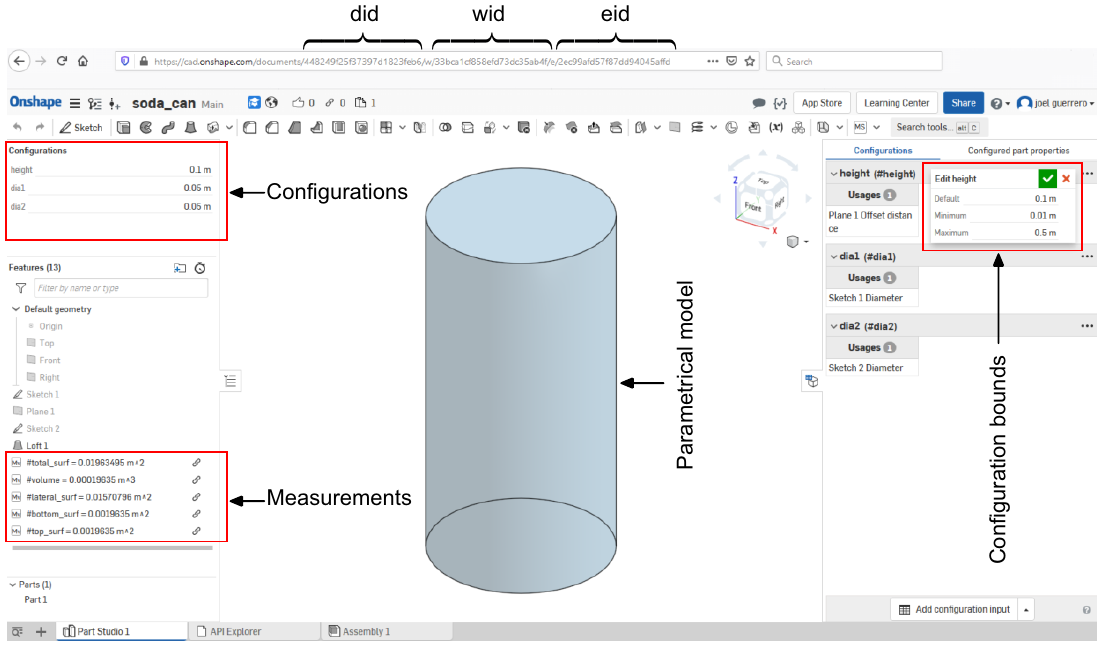
Figure 3. Definition of configuration variables and measurements in the Onshape